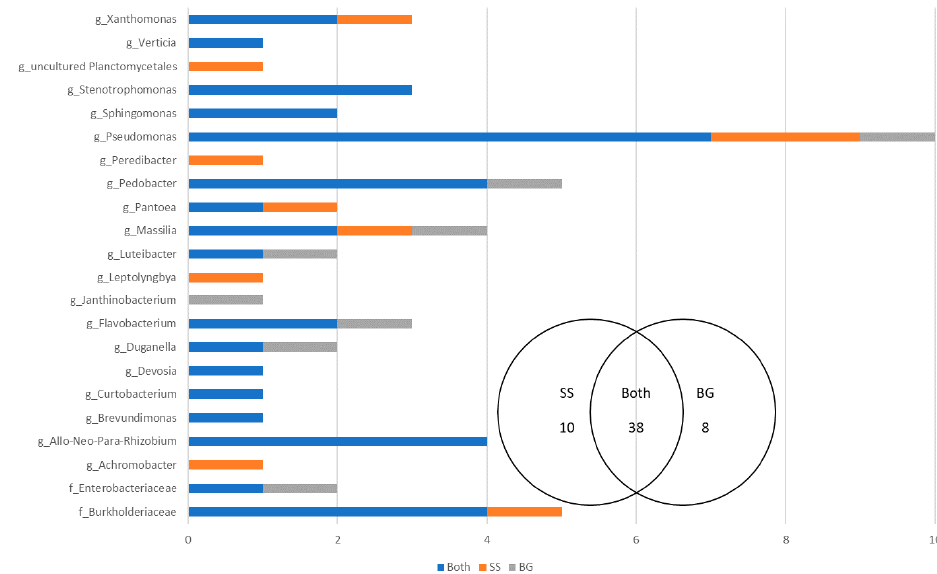
Figure 7. The number of shared and supplemental OTUs between the Single Seeds (SS)—2015–2016 and the Biogeography Seed (BG)—2018.